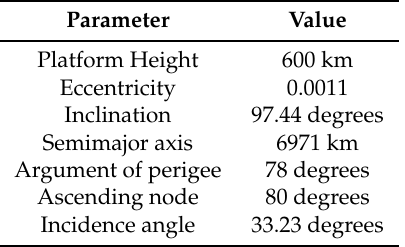
Table 2. Parameters of Satellite Orbit in Simulation